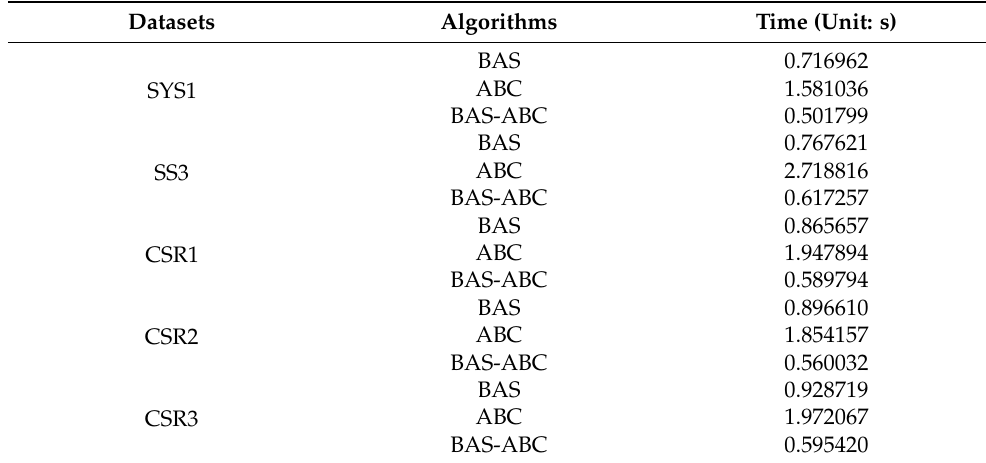
Table 2. The running time of the three algorithms running 20